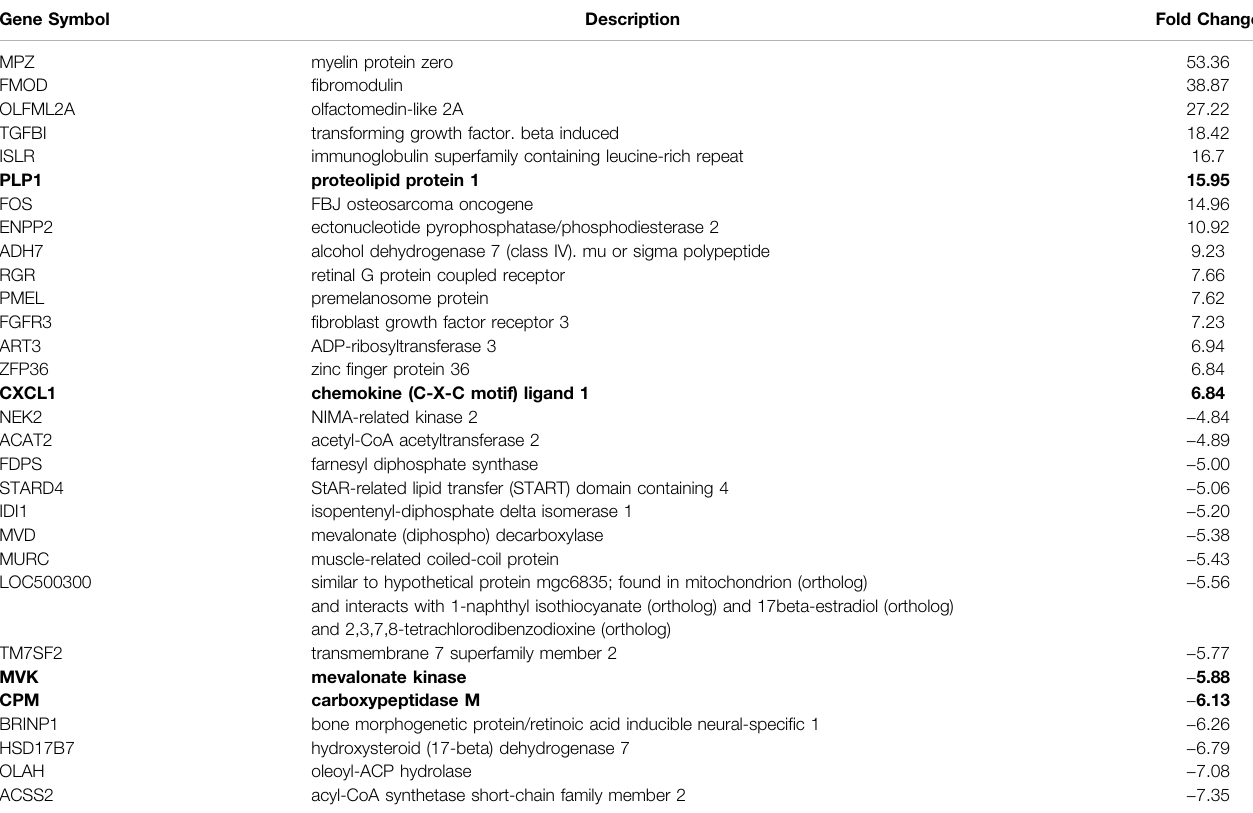
TABLE 2 | Differentially expressed genes in taffazin-de fi cient C6 rat glioma cells (15 top up-regulated and 15 Top down-regulated genes) Gene